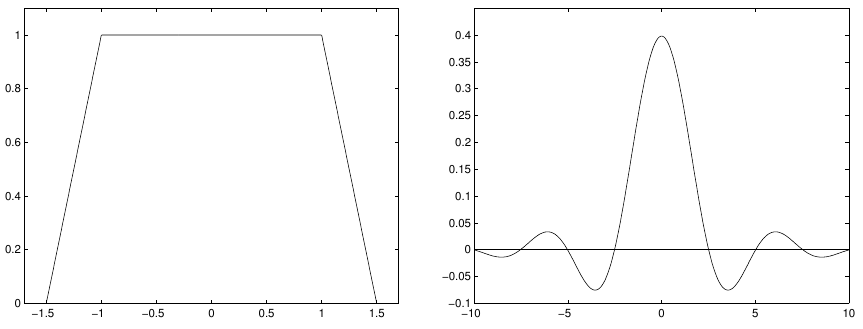
Figure 1. Piecewise linear characteristic function ( left ) and corresponding kernel ( right ), c = 1.5.